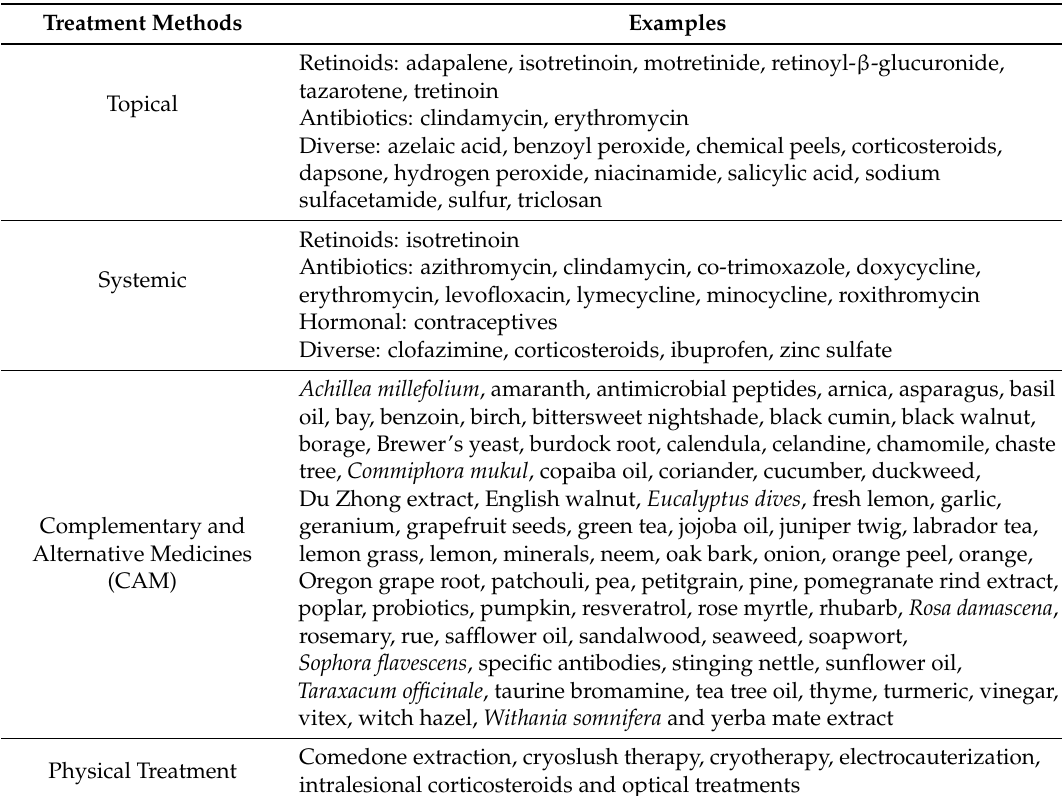
Table 1. Different treatment options for